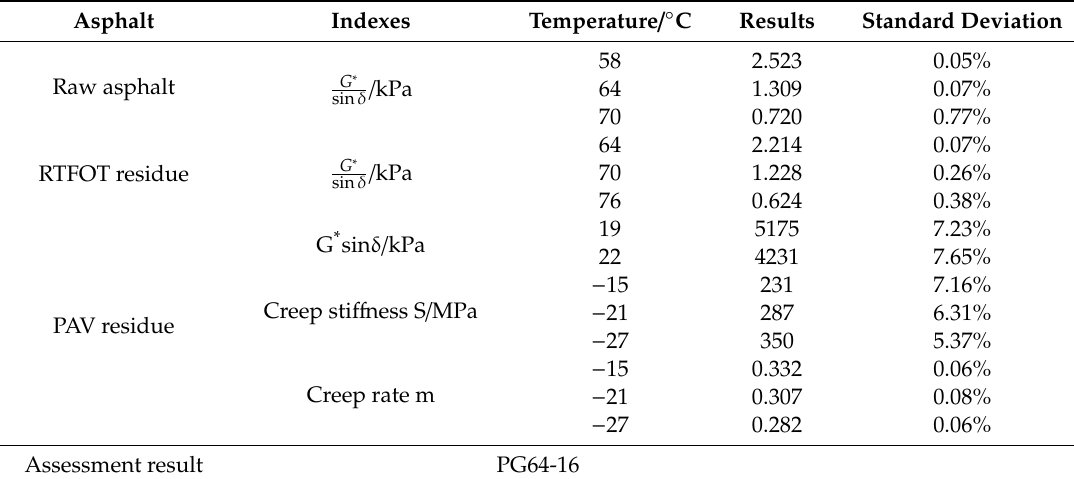
Table 6. PG grade results of SFMA (silica fume modified